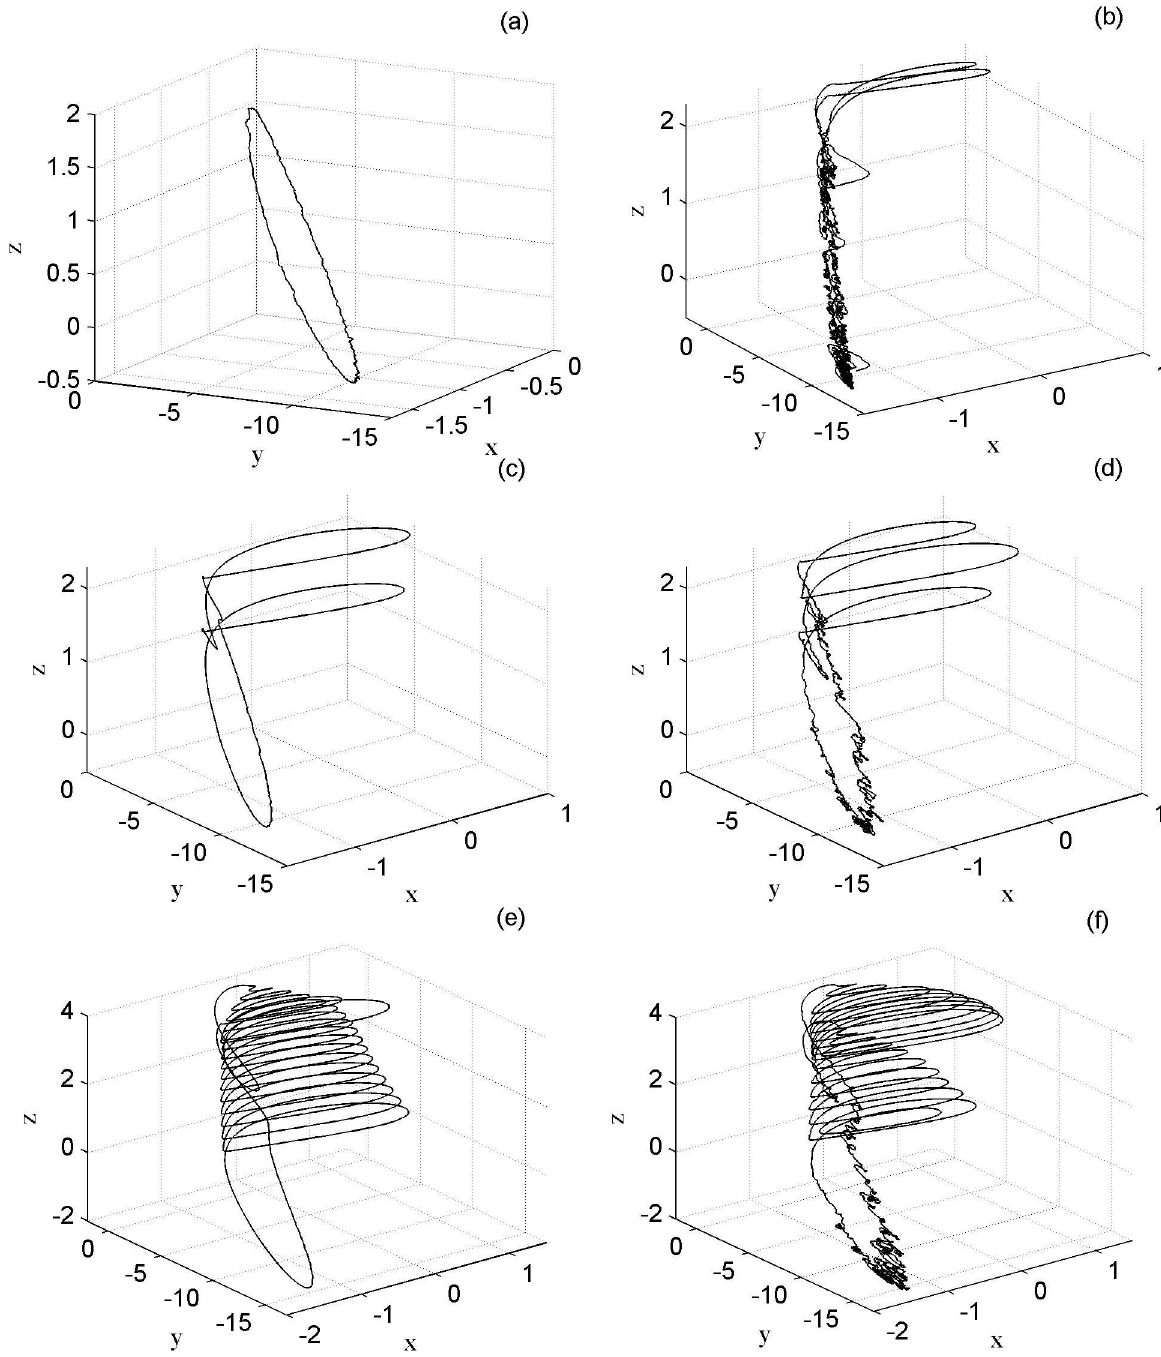
Fig 5. The spatialphase diagrams of electricalactivity under different externalradiation-induced magnet flux (a), (c) and (e) no noise; (b), (d) and (f) Le´vy noise. D = 0.1, α = 1.9 and β = 0. In panel (a), as the Le´vy noise intensity is increased from 0 to 0.1 and then to 1.0, the stationary probability distribution functions of the state that is less than -1.0 decreases, while the stationary probability distribution functions of the state that is large